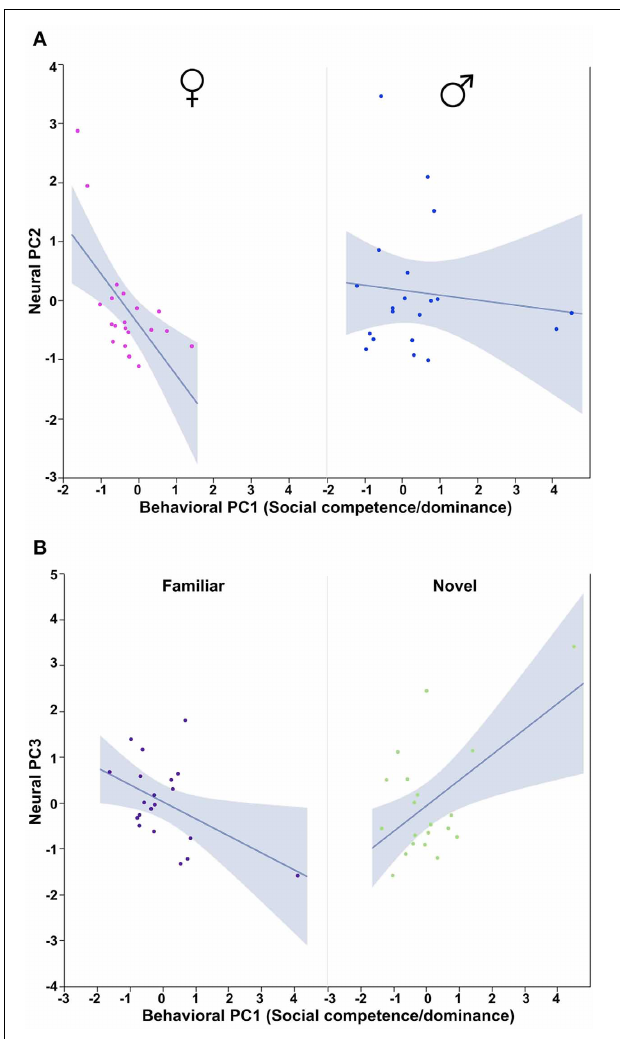
FIGURE 9 | Behavioral PC1 (Social competence/dominance) interacts with Sex to predict Neural PC2, and with Context to predict Neural PC3. (A) The correlation between Behavioral PC1 (Social competence/dominance) and Neural PC2 is strongly negative in females but not males. Sex × Behavioral PC1 F ( 1 , 32 ) = 4 . 71, p = 0 . 04. (B) Social competence/dominance tends to correlate positively with Neural PC3 in subjects exposed to novel same-sex conspecifics, but negatively in subjects exposed to familiar conspecifics. Context × Behavioral PC1 F ( 1 , 32 ) = 13 . 50, p < 0 . 001. The 95% confidence interval is indicated by shading.